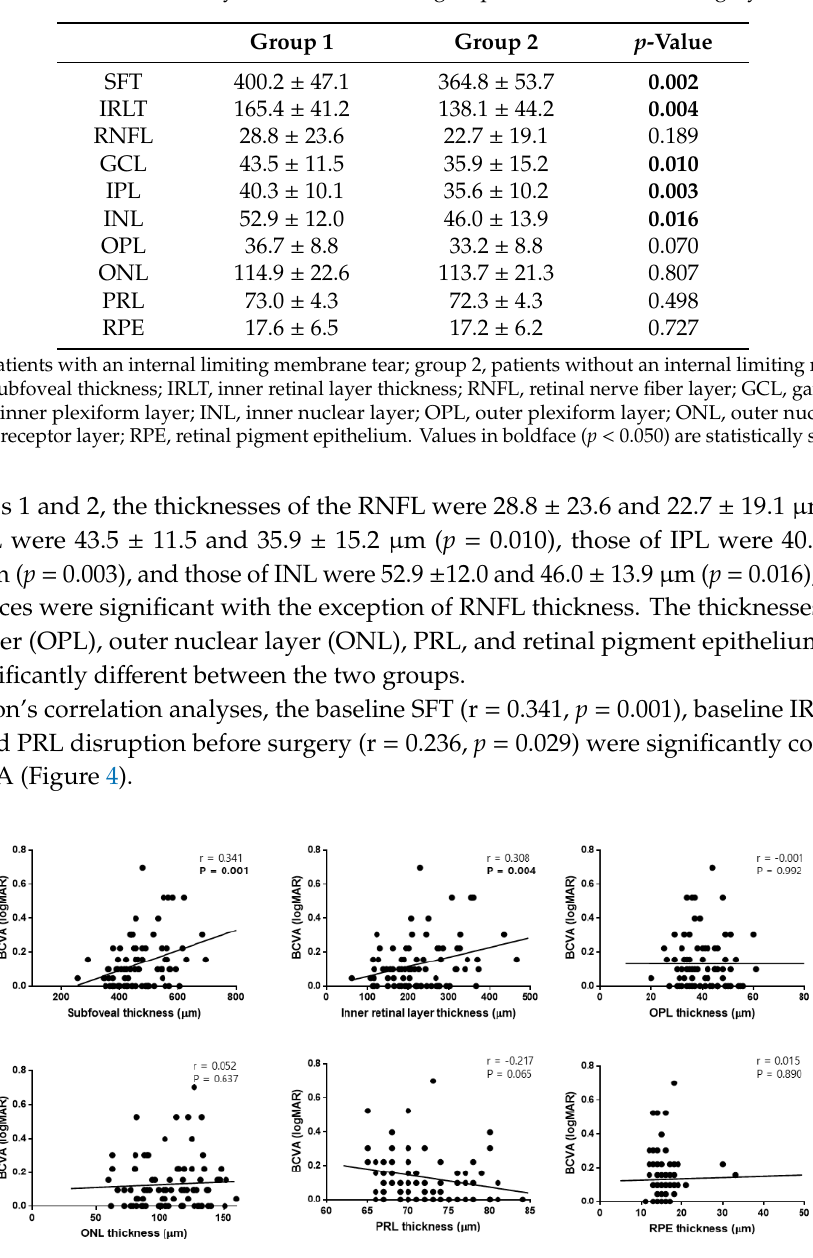
Figure 4. Scatter plots showing the associations between preoperative retinal layer thicknesses and the final best-corrected visual acuity (BCVA) in patients with epiretinal membrane. Preoperative subfoveal thickness and inner retinal layer thickness were significantly correlated with the final BCVA. OPL, outer plexiform layer; ONL, outer nuclear layer; PRL, photoreceptor layer; RPE, retinal pigment epithelium. Additionally, SFT (r = 0.361, p = 0.001), IRLT (r = 0.378, p < 0.001), and OPL (r = 0.259, p = 0.016) thicknesses at 12 months after surgery were correlated with the final BCVA (Figure